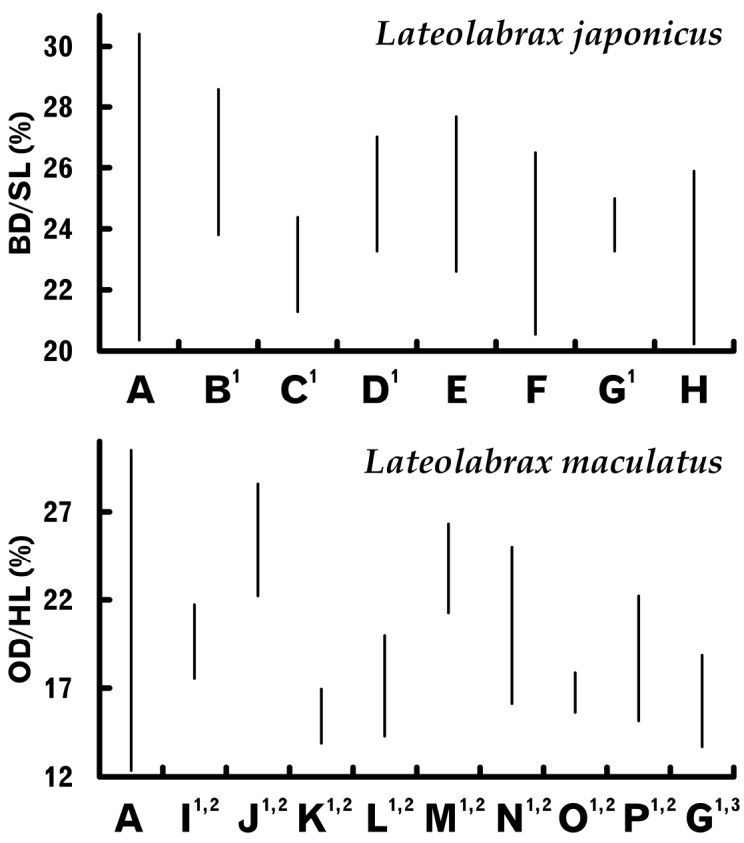
Proportional range comparisons of head length [HL, % of standard length (SL)] in Lateolabraxjaponicus (upper graph, axis labelled BD / SL) and orbital diameter (OD, % of HL) in L.maculatus (lower graph, axis labelled OD / HL) in the present study and previous literature. Data based on A present study BKatayama (1960a)CLindberg and Krasyukova (1969)DChyung (1977)EYokogawa (1995)FNozaka (1995)GYamada et al. (2007)HBae et al. (2016)IChu et al. (1962)JChu (1985)KChen (1987)LZheng (1987)MChen et al. (1990)NMao et al. (1991)OGao (1991)PCheng and Zhou (1997). 1 Proportional percentages were calculated as reciprocal numbers from proportional data (multiple numbers) therein given. 2 Despite descriptions as “L. japonicus,” synonymized as L.maculatus by Yokogawa (2013b). 3 Provisionally referred to as Lateolabrax sp., which was identical with L.maculatus.